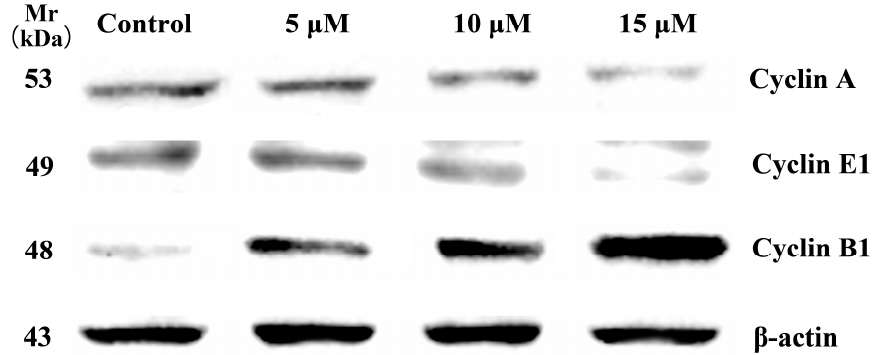
Figure 5. Western blot analysis: Effects of Cyclin A, Cyclin E1 and Cyclin B1 in HCT-116 cells after 24 h treatment with compound 5d at 5, 10 and 15 µ M. β -actin served as an internal control.